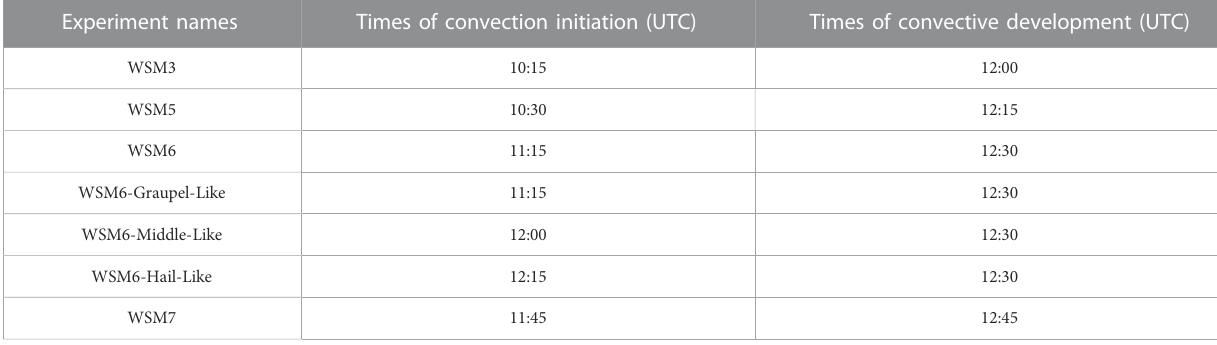
TABLE 2 Times of convective initiation and development for all seven